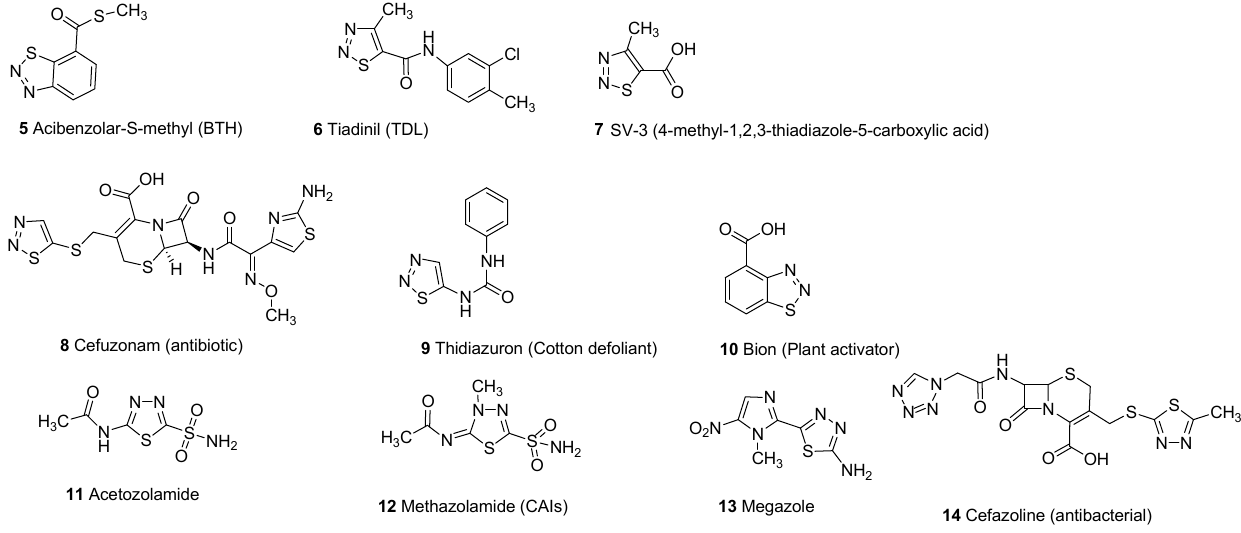
Figure 1. Structures of different isomeric forms of thiadiazole ( 1 – 4 ).